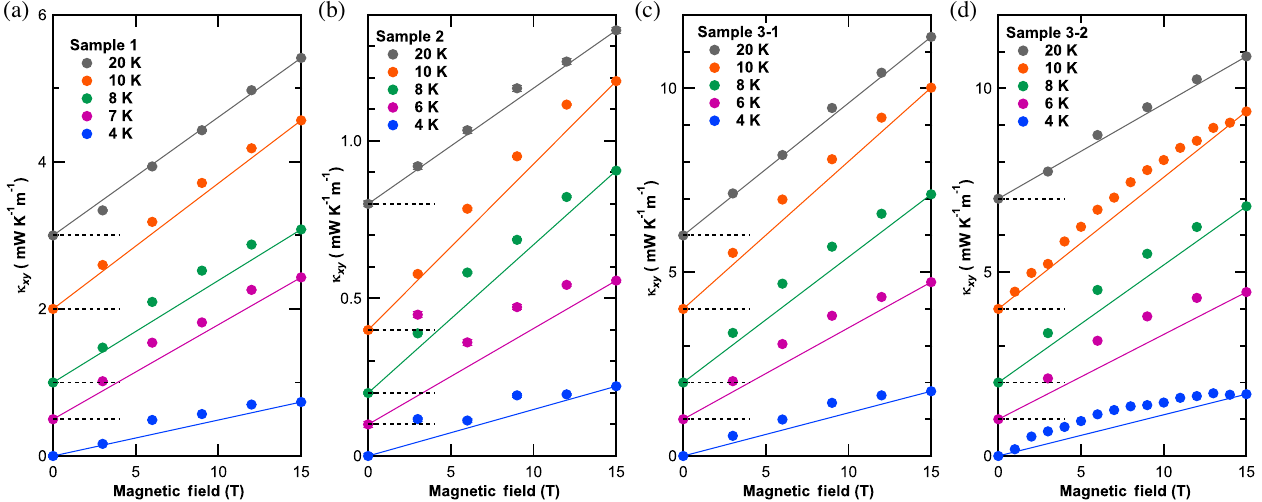
FIG. 5. (a – d) The field dependence of κ of all Cd-K samples for 4 – 20 K. The data above 4 K are shifted for clarity. The offsets for the xy shifted data are indicated by the dashed lines. The solid lines are drawn to show a deviation from the linear increase of κ Error bars estimated by the standard error are smaller than the symbol size for all the